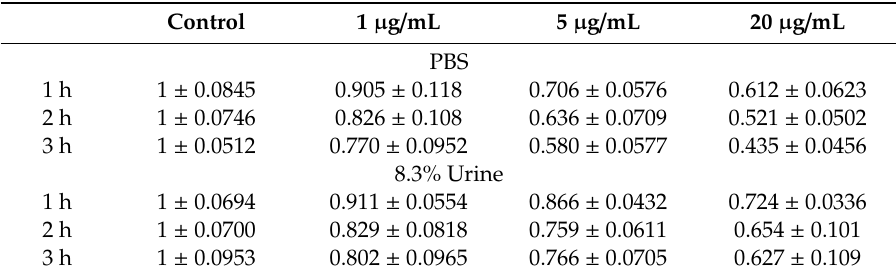
Table1. Atablerepresentationoftherelativeintensityvalues ± SDoftime-andconcentration-dependent changes in HexCoil-Ala-SWCNTs’ photoluminescence after incubation with trypsin in PBS or in 8.3% v / v urine. p < 0.05, n = 4.